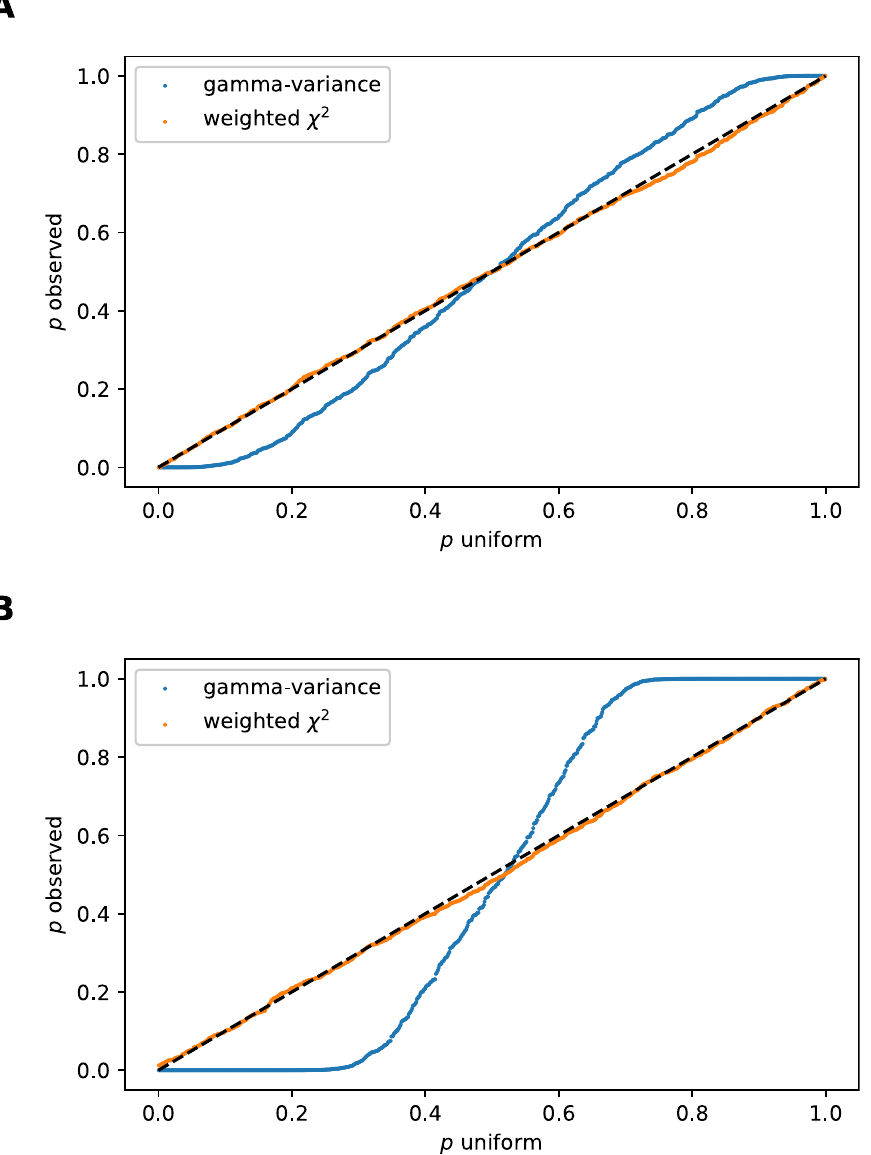
Fig 2. QQ-plots of observed p -values resulting from the index I for 1000 pairs of samples of N ð 0 ; S Þ against uniform p -values. A: Off-diagonal elements of S set to 0.2. B: Off-diagonal set to 0.8. The blue curve is obtained using the variance-gamma distribution to perform the statistical test, while the orange curve is obtained via the weighted χ 2 distribution. The latter corrects for the correlation and therefore is well